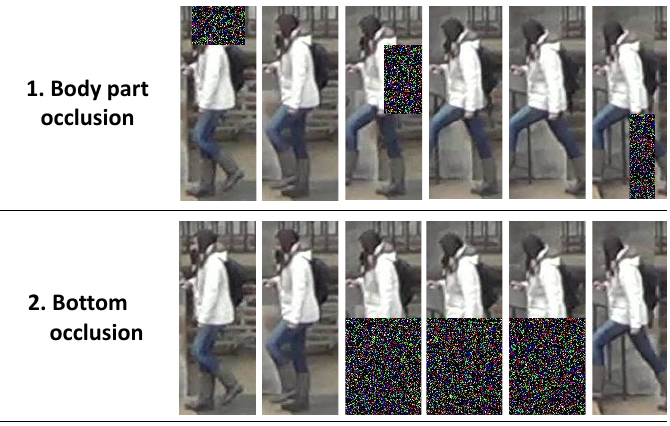
Figure 7. Examples of two occlusion